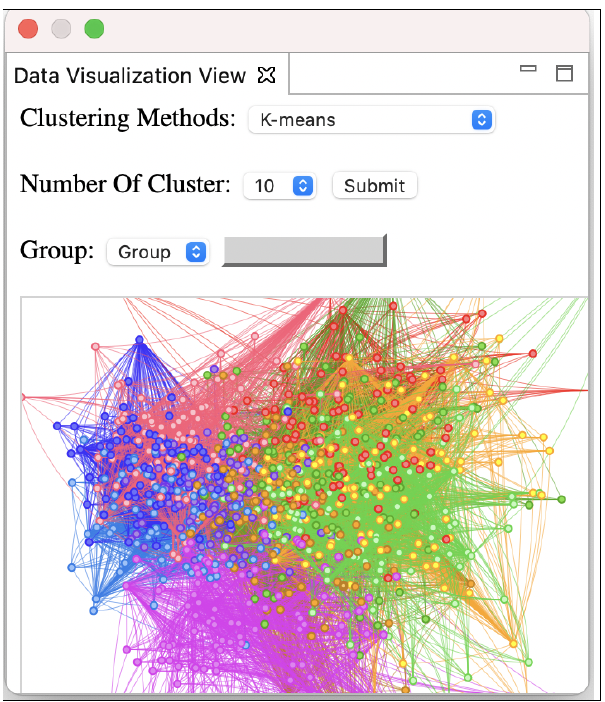
Figure 9. The tool screenshot of Data Visualization View